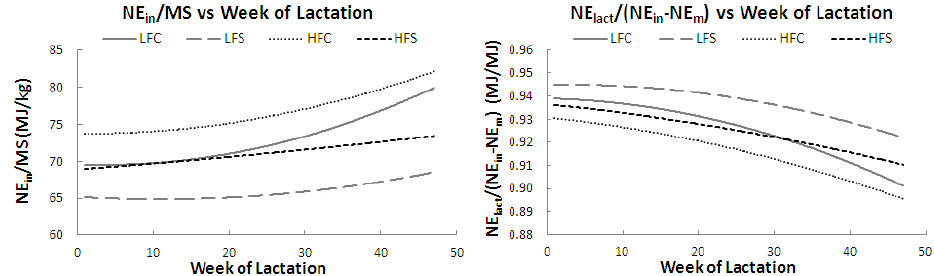
Figure 2. Fitted polynomial trend lines to biological energy efficiencies plotted against week of lactation. LFC stands for Low Forage Control, LFS for Low Forage Select, HFC for High Forage Control and HFS for High Forage